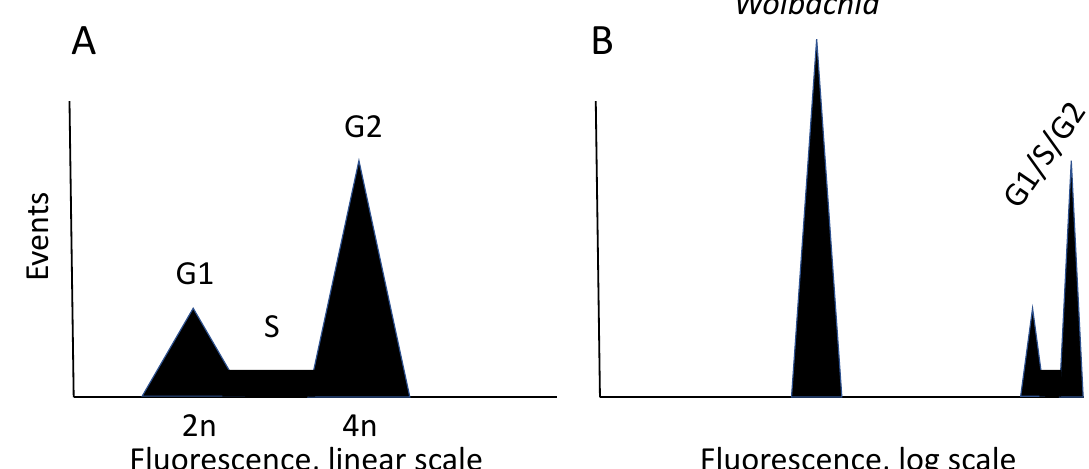
Figure 1. Use of a flow cytometer for evaluating Wolbachia abundance. Flow cytometry involves staining a subcellular component, such as DNA, with a fluorescent dye. For DNA, propidium iodide is commonly used. In the instrument, stained cells flow past a detector that records the dye amount, which is displayed on a histogram. Panel ( A ) shows a schematic representation of a typical image obtained with a growing culture of cells. In a mixed population of cells, individual cells independently traverse the cell cycle. Immediately after mitosis, a cell has a diploid content of DNA, which is called G1. As DNA is synthesized, DNA content increases. This increase is represented by the S (synthesis) phase of the cycle. When synthesis is complete, cells have a G2 DNA content. The fluorescence in G2 is double that of G1, as is the total amount of DNA in a cell. In a cell cycle histogram, the X -axis is on a linear scale, and areas under the curves are proportional to the percentage of the population in that particular phase of the cycle. ( B ). To detect Wolbachia in the same sample, the position of host cell cycle events is electronically shifted to the far right of a histogram with the X -axis on a log scale, allowing particles with lower amounts of DNA to be detected. Details of conditions for visualizing Wolbachia by flow cytometry are described elsewhere [83].